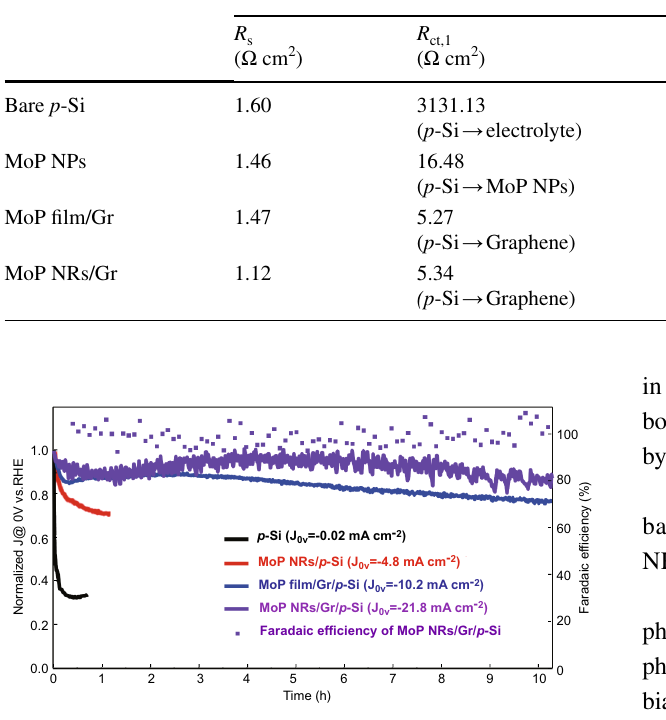
Fig. 6 Long‑term stability tests for the bare p‑Si, MoP NPs/p‑Si, MoP film/Gr/p‑Si, and MoP NRs/Gr/p‑Si photocathodes at 0 V ver‑ sus RHE and Faradaic efficiency for MoP NRs/Gr/p‑Si